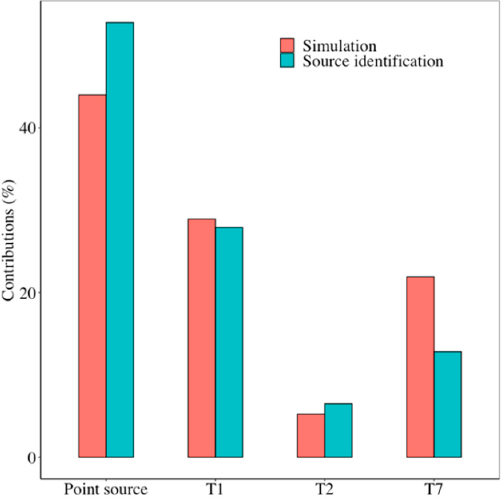
Figure 6. Contributions of tributaries (T1, T2 and T7) and point source to NO 3 − -N in the outlet of Yuntaishan River. Simulation was conducted based on the mass balance.